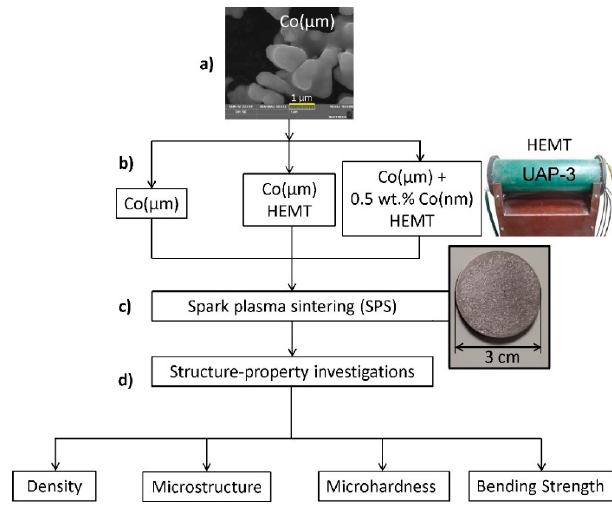
Figure 4. An overview of the experimental plan.